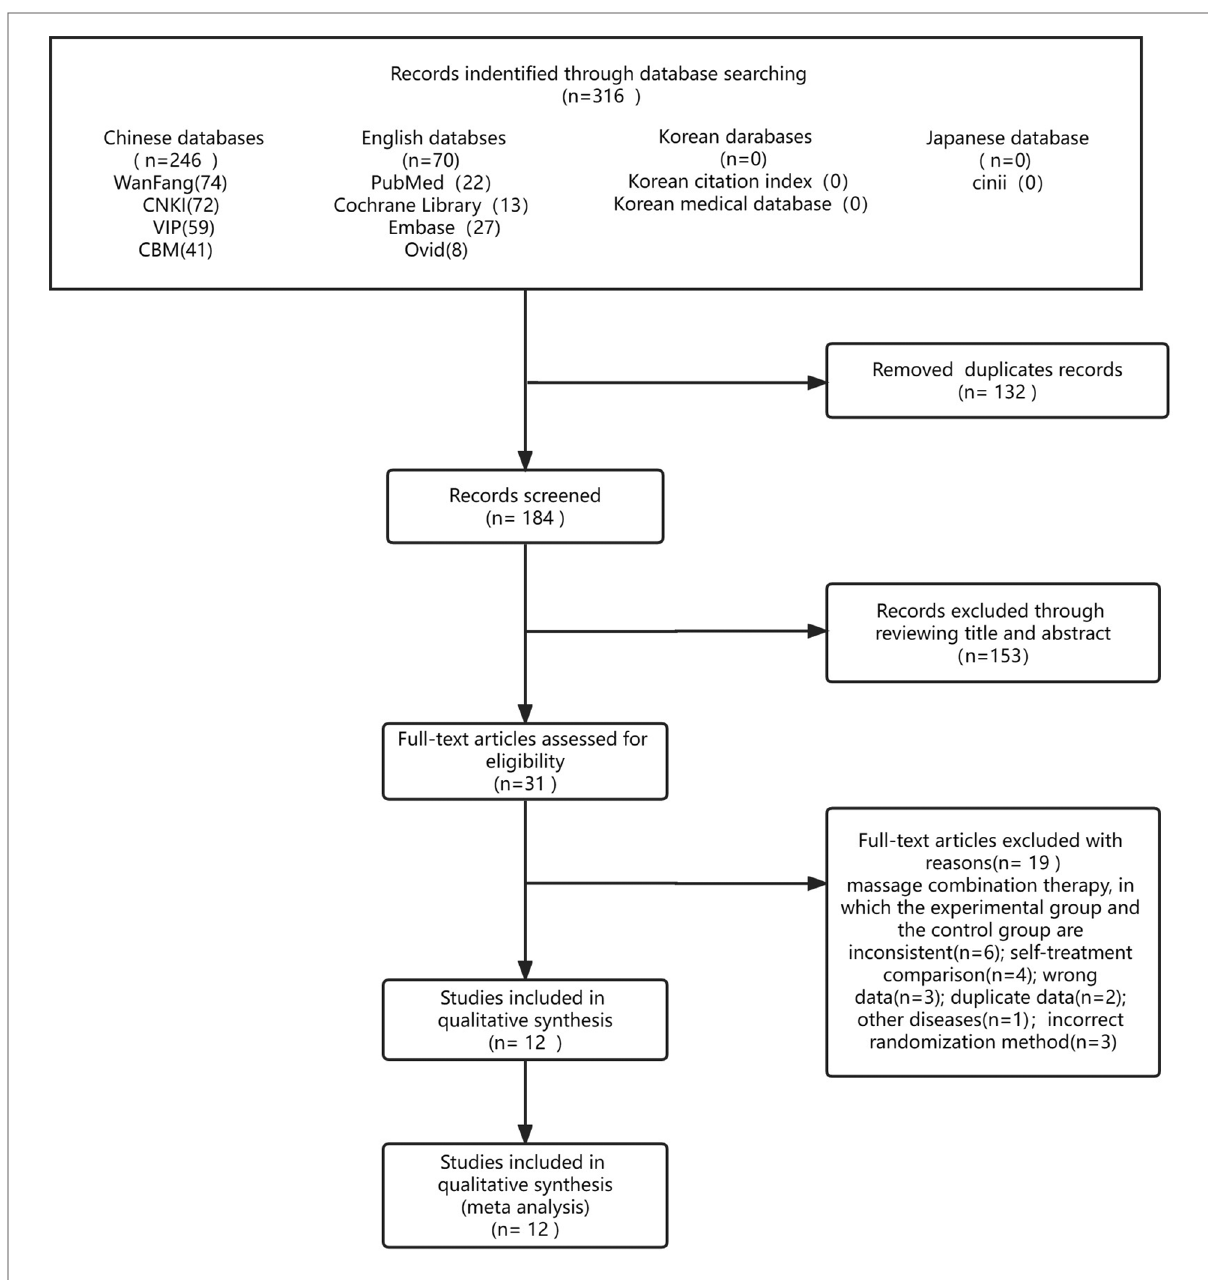
FIGURE 1 Flowchart for literature